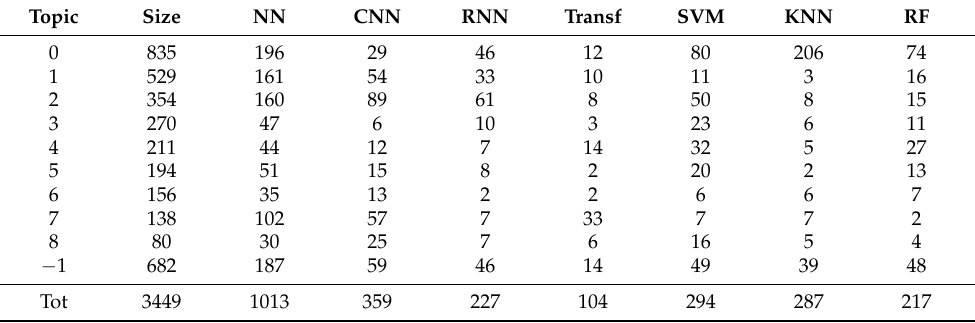
Table 4. Count of the number of occurrences of various ML models for each